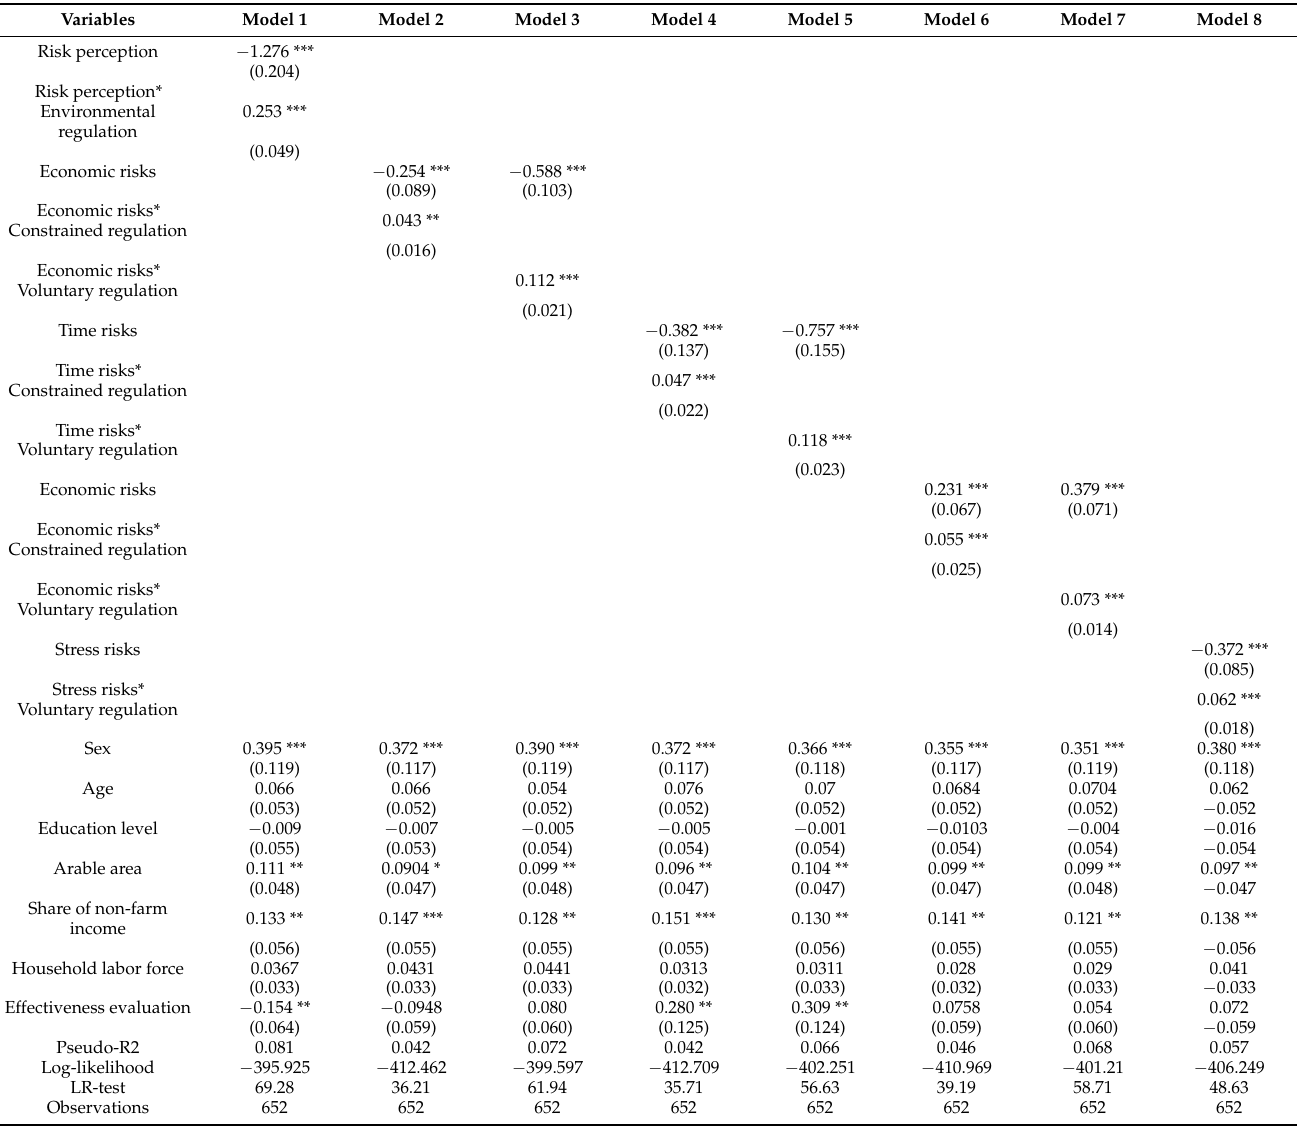
Table 5. Regression results of moderating effects from environmental regulation and its dimensions ( n =